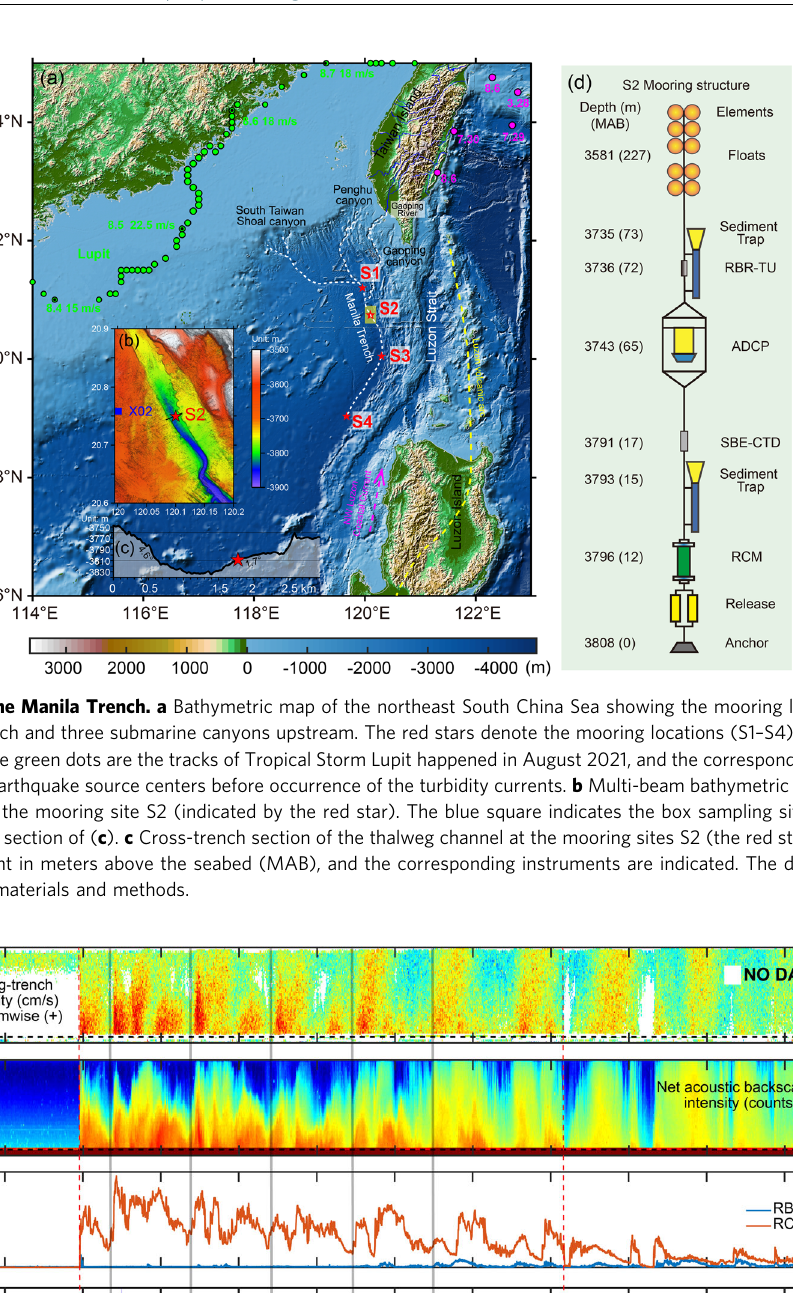
COMMUNICATIONS EARTH & ENVIRONMENT| (2023) 4:108 |https://doi.org/10.1038/s43247-023-00776-8|www.nature.com/commsenv